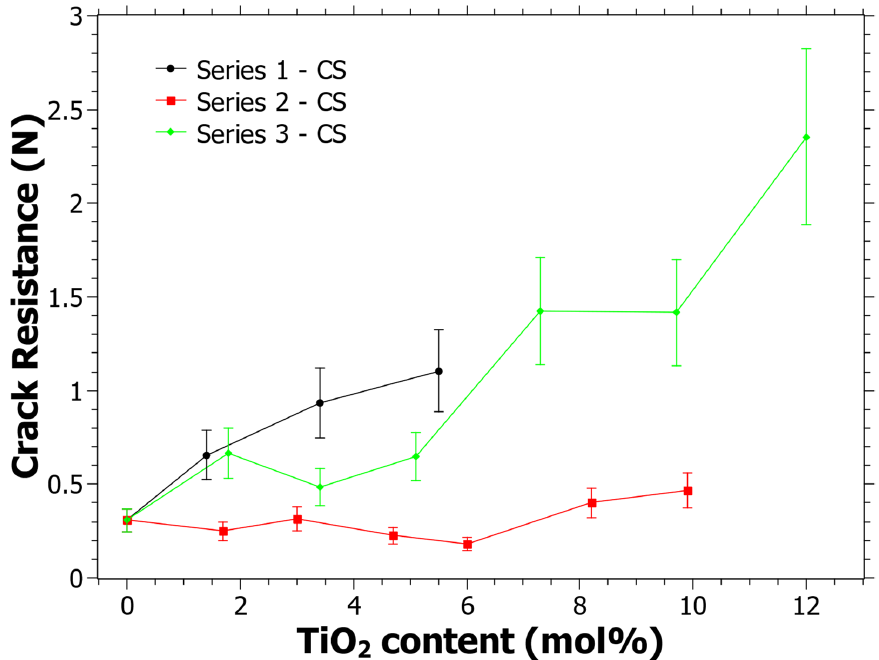
Figure 5. Crack resistance (CR) as determined using a Vickers indenter and when the percentage of radial crack initiations is equal to 50% following the procedure in ref [51]. Estimated error is 20% of the CR value and is shown by the error bars in the graph.